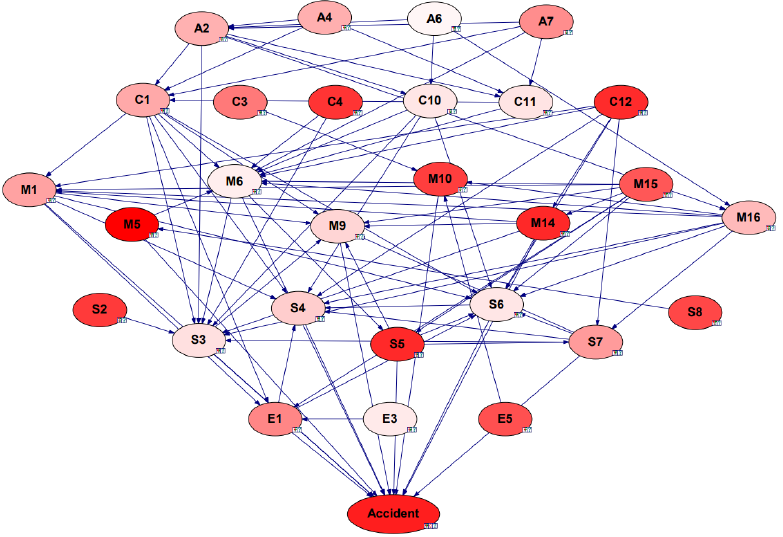
Figure 12. Result of Bayesian network sensitivity analysis.